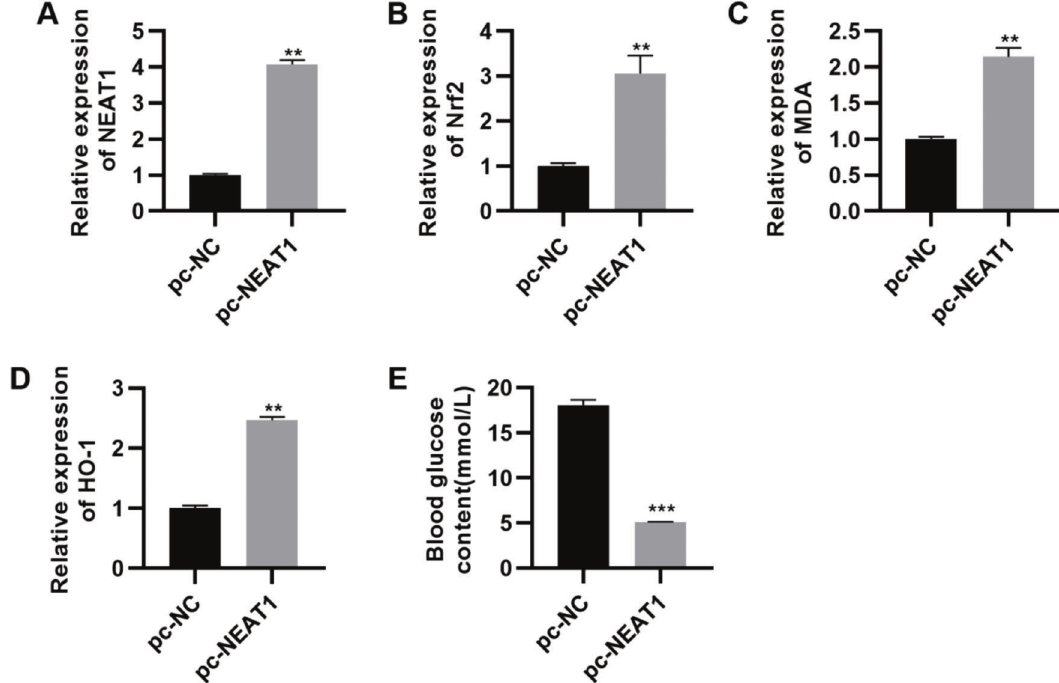
Figure 5 - pc-NEAT1 upregulated the expression of NEAT1 and Nrf2 pathway-related genes. A-D, Transfection of pcDNA3.1- NEAT1 upregulated the expression of NEAT1 and Nrf2 pathway-related genes and E, decreased blood glucose levels in rats with diabetic cardiomyopathy (DCM). ** p o 0.01, *** p o 0.001, Mann-Whitney U test.